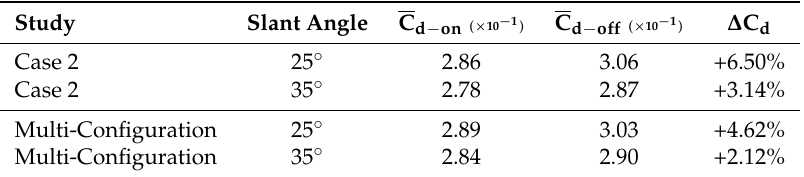
Table 6. Drag reduction at Re = 2.25 × 10 5 with actuator frequency at 4.5